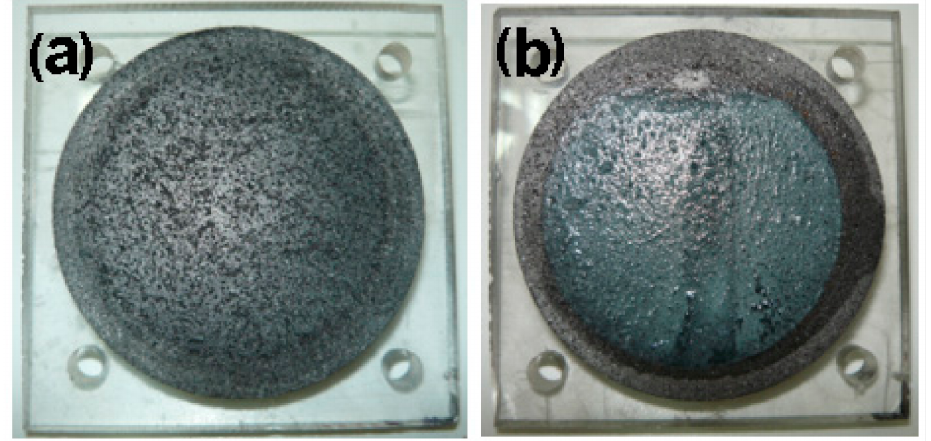
Figure 4. Image of cathode electrode surface before ( a ) and after ( b ) metallic zinc layer